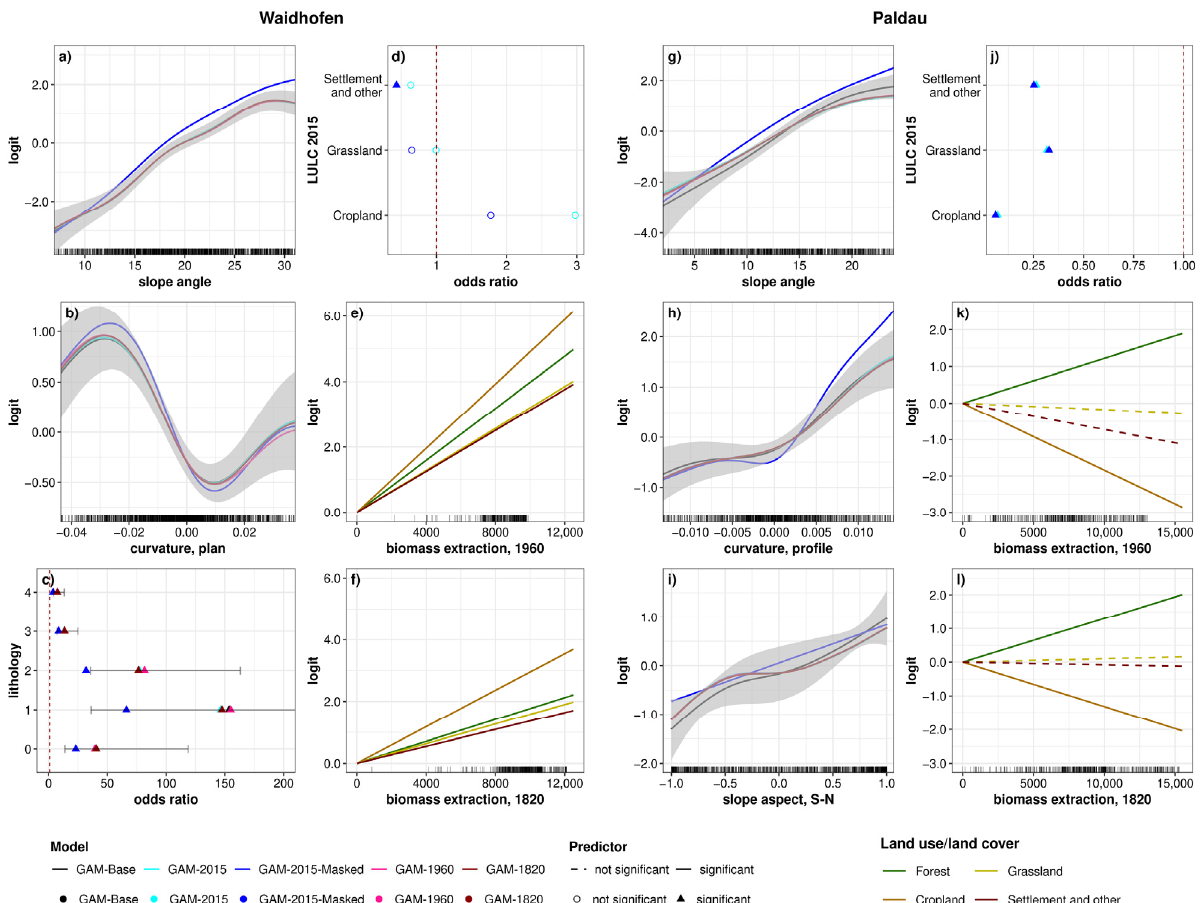
Figure 5. Comparison of predictor-response relationships of the three most important predictors (left column, ( a – c ) and ( g – i )) and the LULC legacy variables (right column, ( d – f ) and ( j – l )) for each study area. Grey: 95% Bayesian credible interval of GAM-Base. Lithological units in Waidhofen: Reference unit: ‘Upper Austroalpine limestone’, 0: talus and glacial deposits, 1: Inneralpine Neogene, 2: Klippen zone, 3: flysch zone, 4: Upper Austroalpine marls. Note: the y axes are plot-dependent, and the x axes of non-parametric transformation functions are limited to the 5th to 95th percentile range.